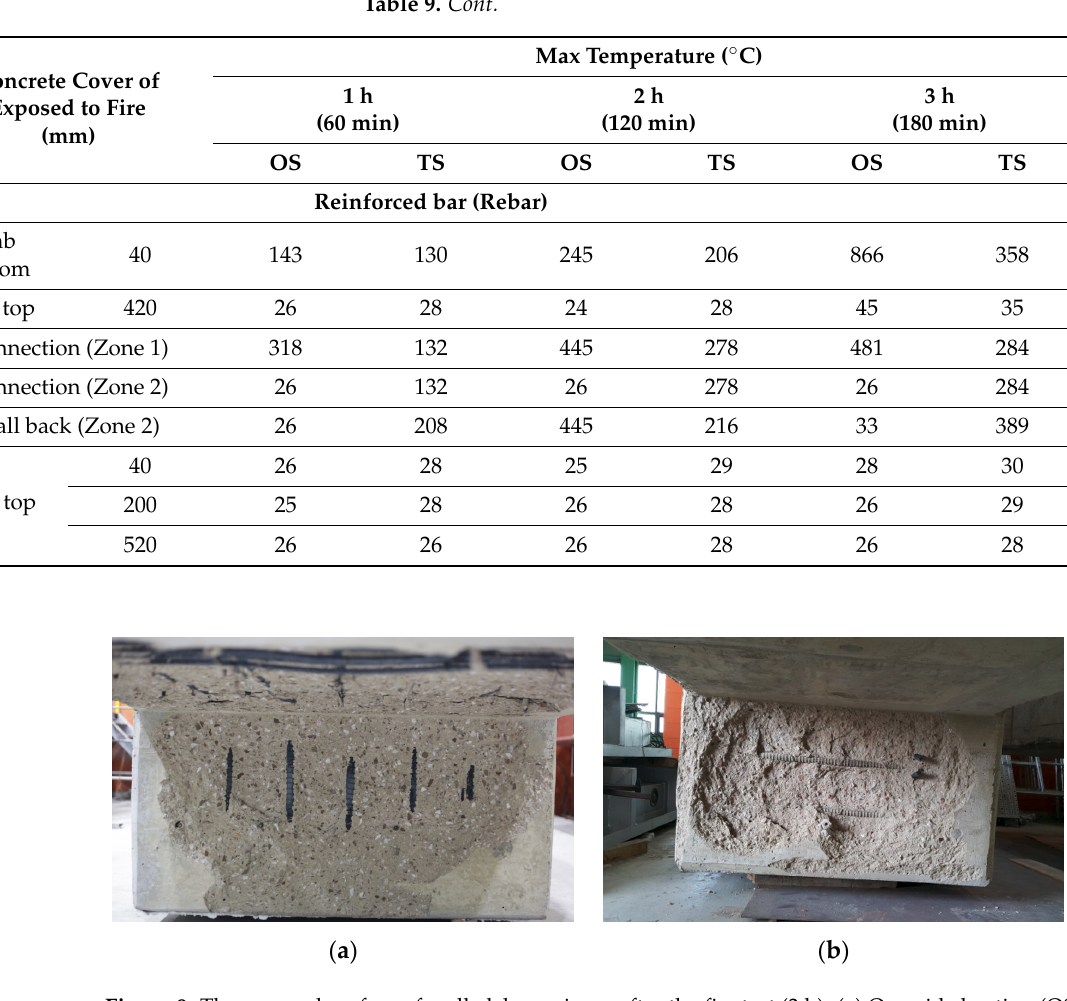
Figure 9. The exposed surface of wall-slab specimen after the fire test (3 h): ( a ) One-side heating (OS); ( b ) two-side heating (TS).